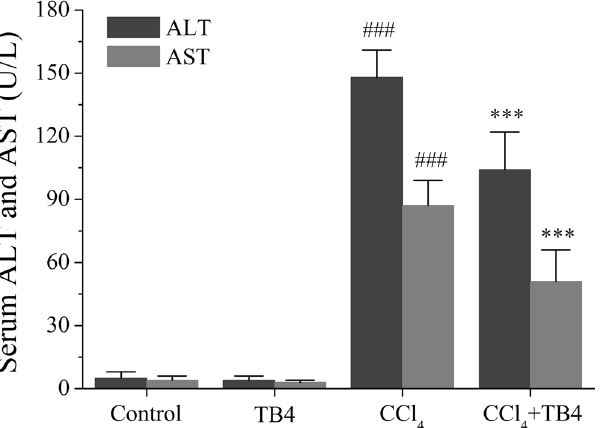
Figure 1. Effect of exogenous thymosin β 4 (TB4) on serum alanine aminotransferase (ALT) and aspartate aminotransferase (AST) activities of mice in CCl 4 -induced hepatotoxicity. ### P < 0.001 vs. both control group and TB4 group; *** P < 0.05 vs. CCl 4 group. (n = 10 for each